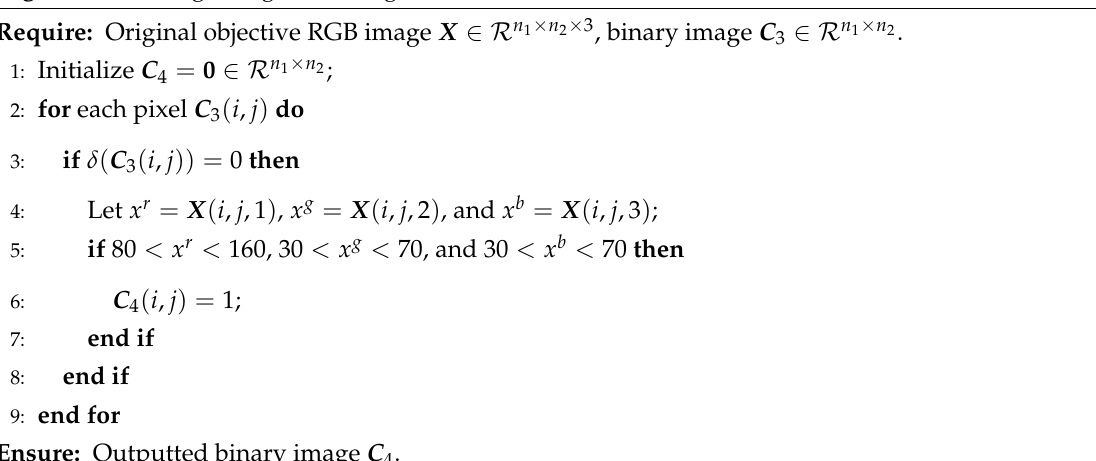
Algorithm 5 Recognizing ear